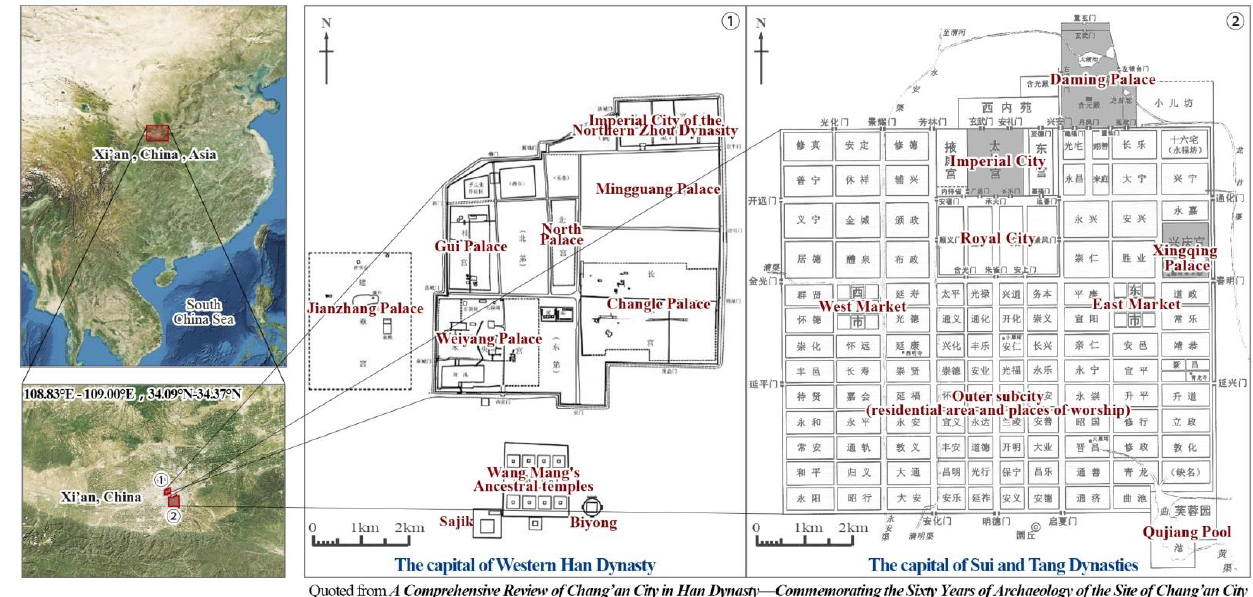
Figure 1. Ichnographies of the capitals of the Western Han dynasty as well as the Sui and Tang dynasties drawn by archaeologists.